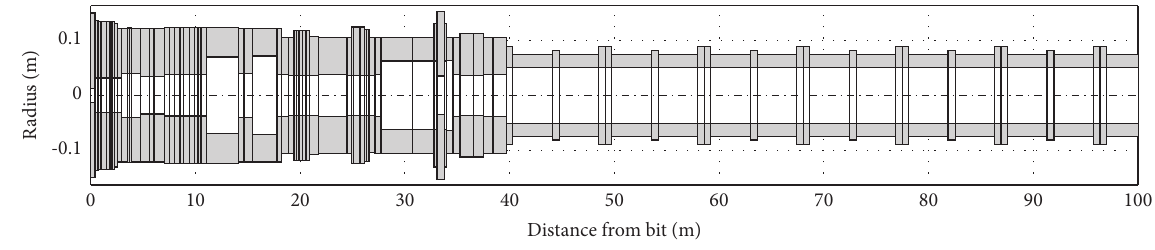
Figure 2: Model of a generic drill